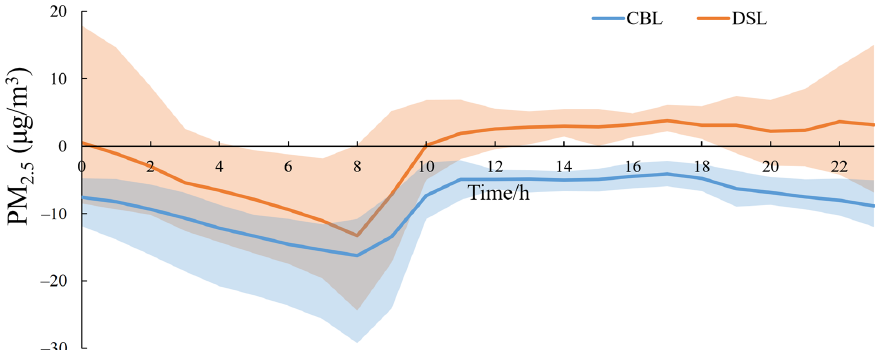
Figure 5. Diurnal variations of the near-surface PM 2.5 concentration differences ( μ g/m 3 ) between the simulations from the lake experiment and no-lake experiment, averaged over CBLs and DSLs during the air pollution process of 19–22 January 2018. The shaded regions are the extreme value intervals over CBLs and DSLs.